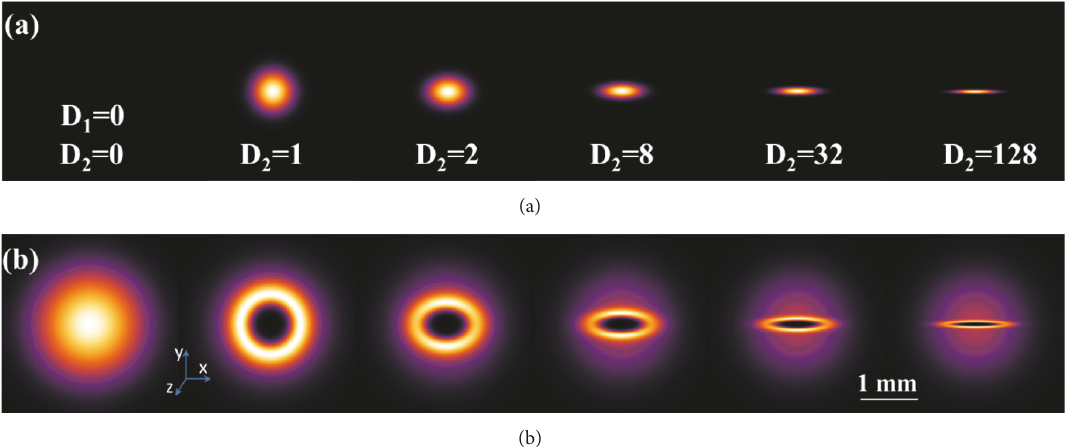
Figure 1: (a) Spatial distribution of control laser beams with D 1 =1, D 2 =1, 2, 8, 32, and 128. (b) Spatial intensity profile of signal laser beams under different control beams in Figure 1(a).